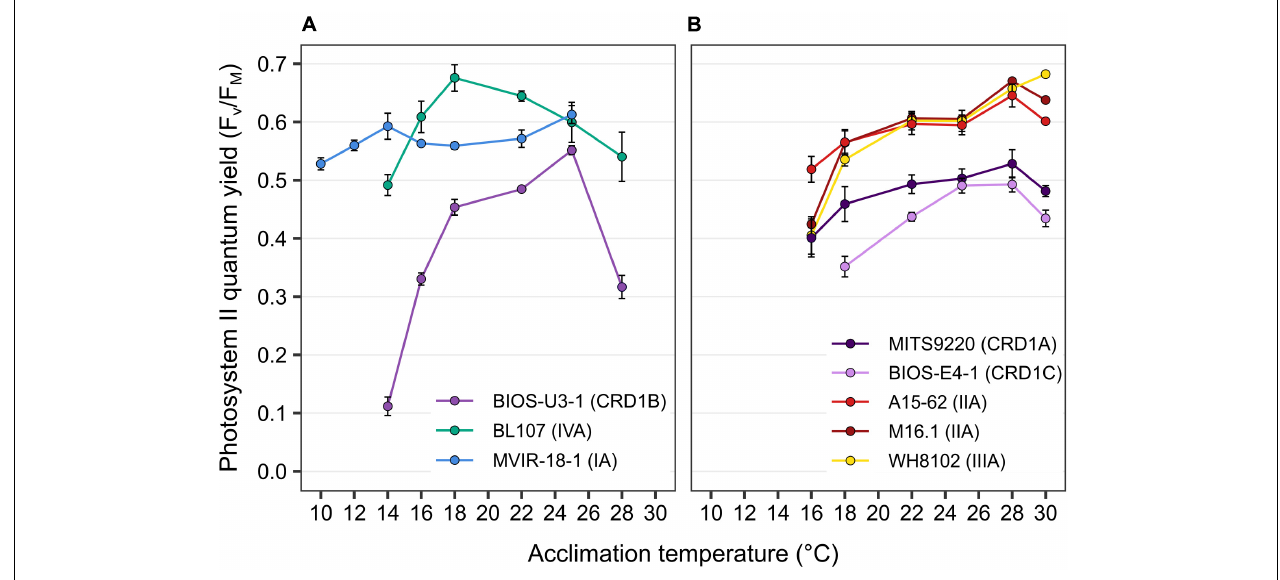
FIGURE 2 | Variation with growth temperature of photosystem II quantum yield ( F V / F M ) for CRD1 vs. clade I, II, III, and IV strains. (A) CRD1-B strain BIOS-U3-1 vs. cold thermotypes. (B) CRD1-A strain MITS9220 and the CRD1-C strain BIOS-E4-1 vs. warm thermotypes. The insert indicates the strain names and their corresponding ESTU ( sensu Farrant et al., 2016) between